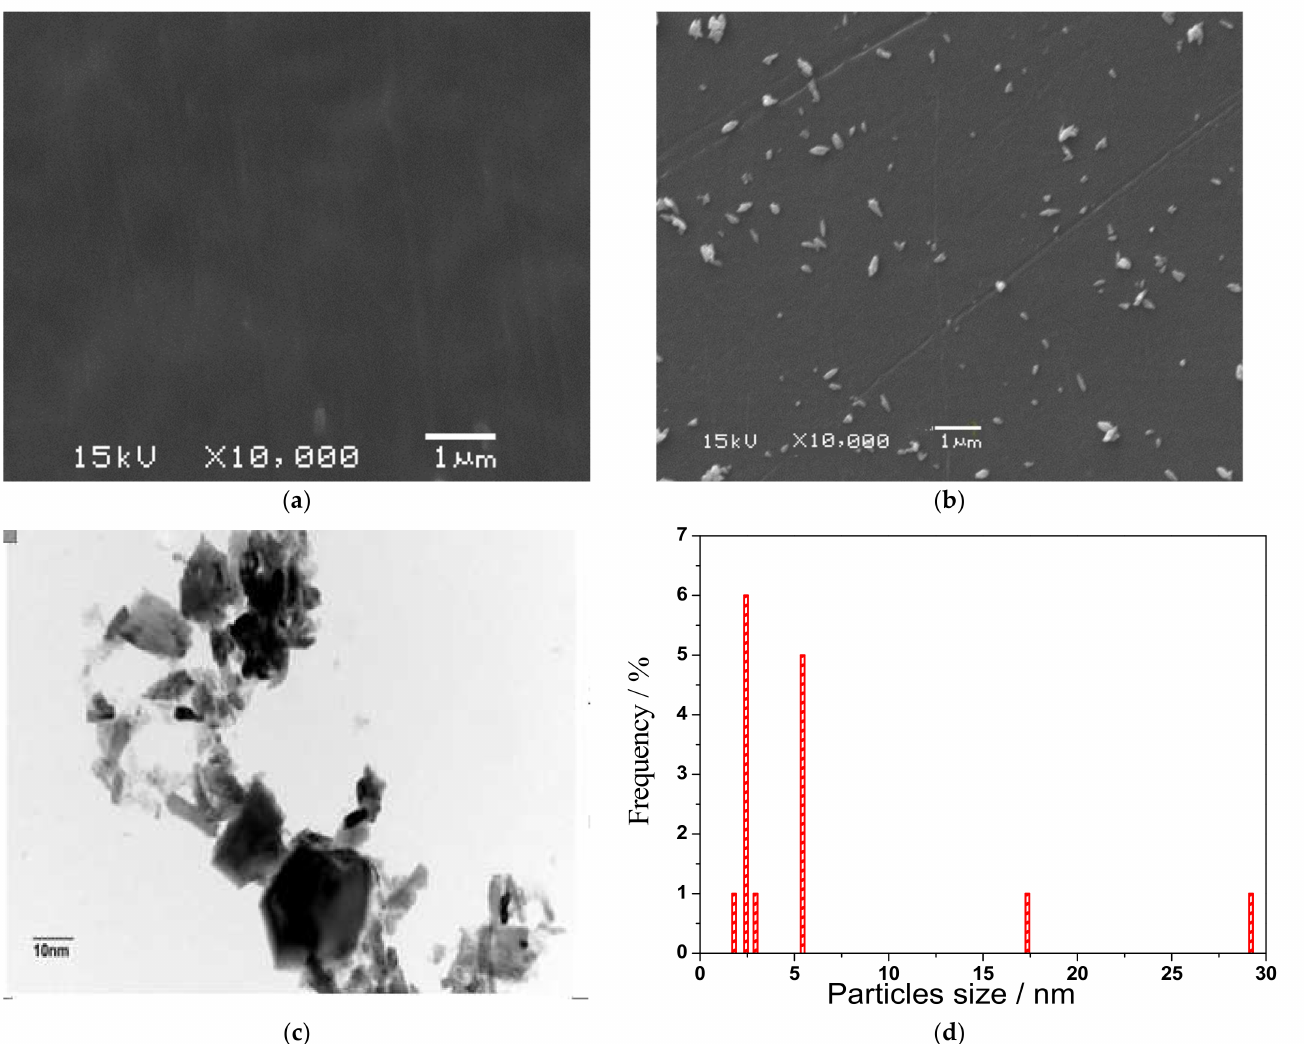
Figure 2. SEM images for ( a ) the undoped membrane surface and ( b ) the S-PVA/IC/SO 4 ZrO 2 -7.5 membrane surface; ( c ) TEM image for SO 4 ZrO 2 nanoparticles and ( d ) frequency distribution plot of SO 4 ZrO 2 nanoparticles size.